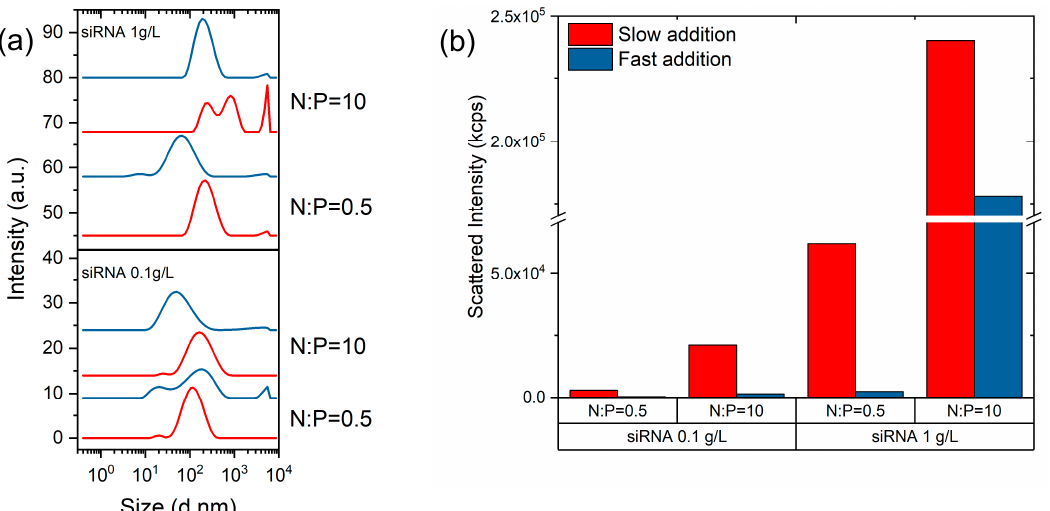
Figure 4. A dynamic light scattering (DLS) analysis of COS-50 / siRNA complexes prepared by the dropwise addition (red) or one-shot injection (blue) of the component in default. The intensity-average size distributions of complexes ( a ) and the corresponding scattered intensities at 173 ◦ detection angle ( b ). The complexation was studied at two siRNA concentrations (0.1 g / L and 1 g / L) in RNase-free water and two N:P ratios (0.5 and 10).